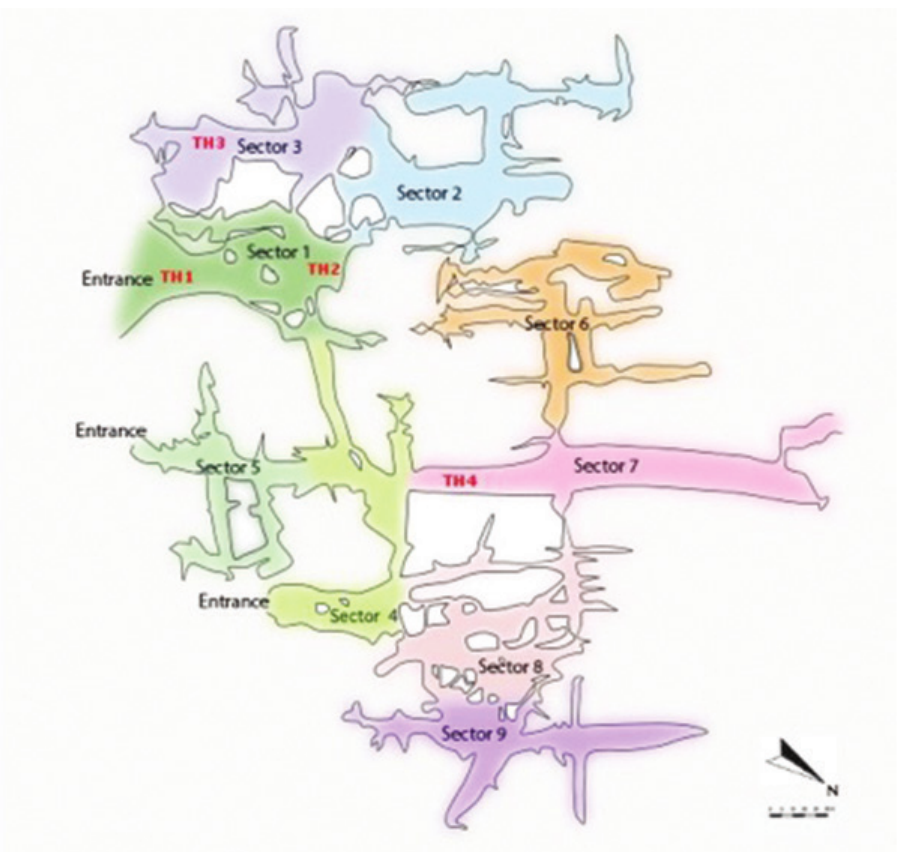
Figure 1. Lapa Nova Show cave map depicting the sectors: green tones correspond to entrance areas; the other six colors correspond to deeper regions of the cave. Legend: (TH) Temperature measurement